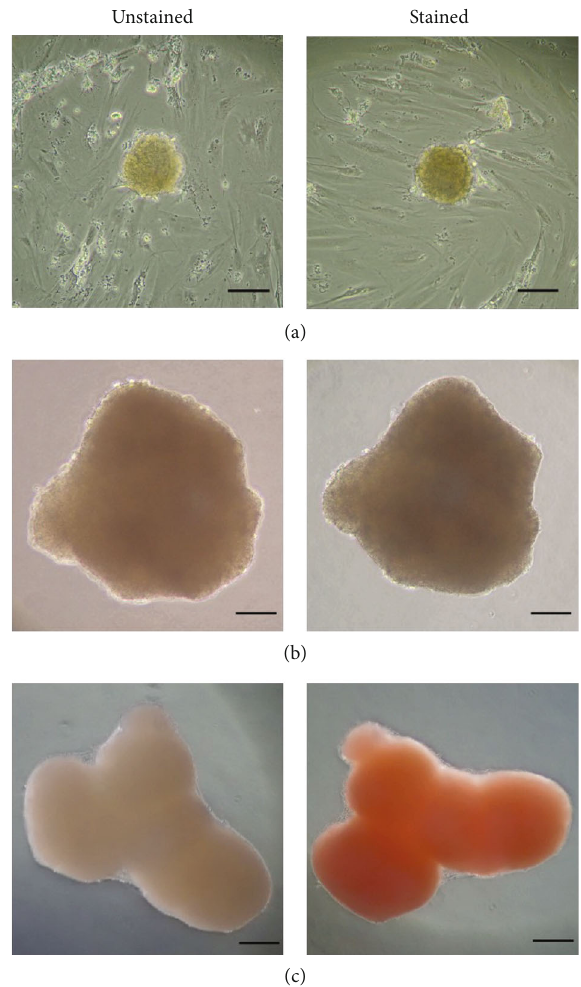
Figure 1: Dithizone staining of canine adipose tissue-derived mesenchymal stem cells at the end of in vitro di ff erentiation. (a) Cells cultured in the di ff erentiated protocol using the two- dimensional culture system using an attachment plate. (b) Undi ff erentiated adipose tissue-derived mesenchymal stem cells using the three-dimensional culture system with μ -pieces. (c) Di ff erentiated adipose tissue-derived mesenchymal stem cells using the three-dimensional culture system with μ -pieces. Bar = 200 μ m